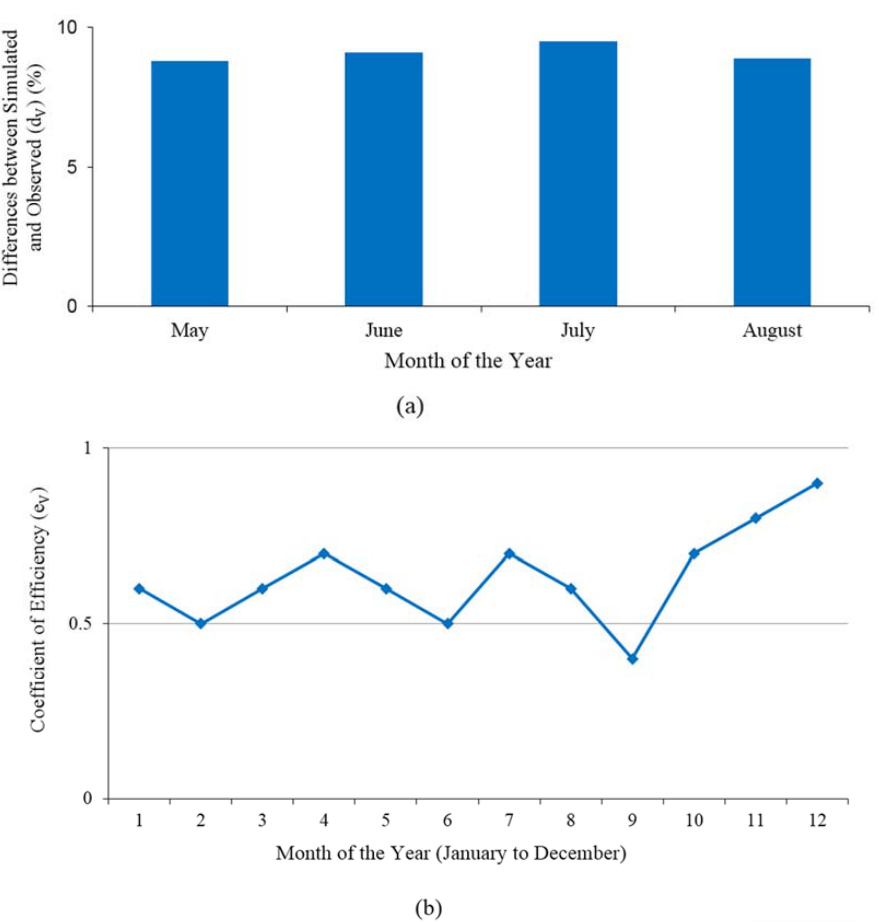
Figure 16. Performance evaluation of the proposed reservoir power curve estimation based on: ( a ) differences between the simulated and observed reservoir storage volumes ( V d ); and ( b ) the Nash ‐ Sutcliffe coefficient of efficiency ( V e ) trend over 12 ‐ months.